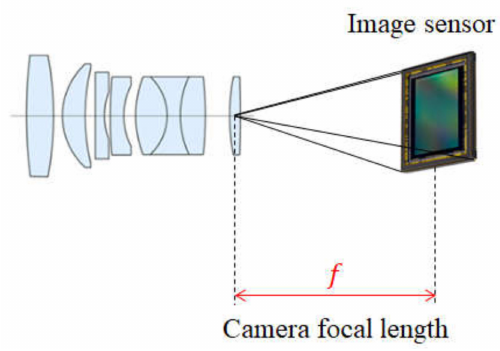
Figure 3. Intrinsic parameter of a camera (focal